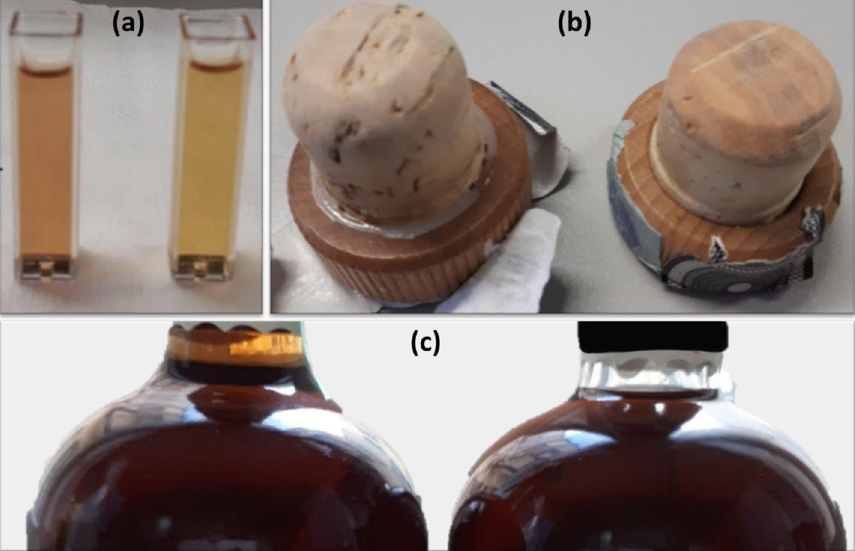
Figure 1. Main visual differences between the suspicious sample (always on the left) and the orig- inal one (on the right): ( a ) color; ( b ) plug; ( c ) level of the